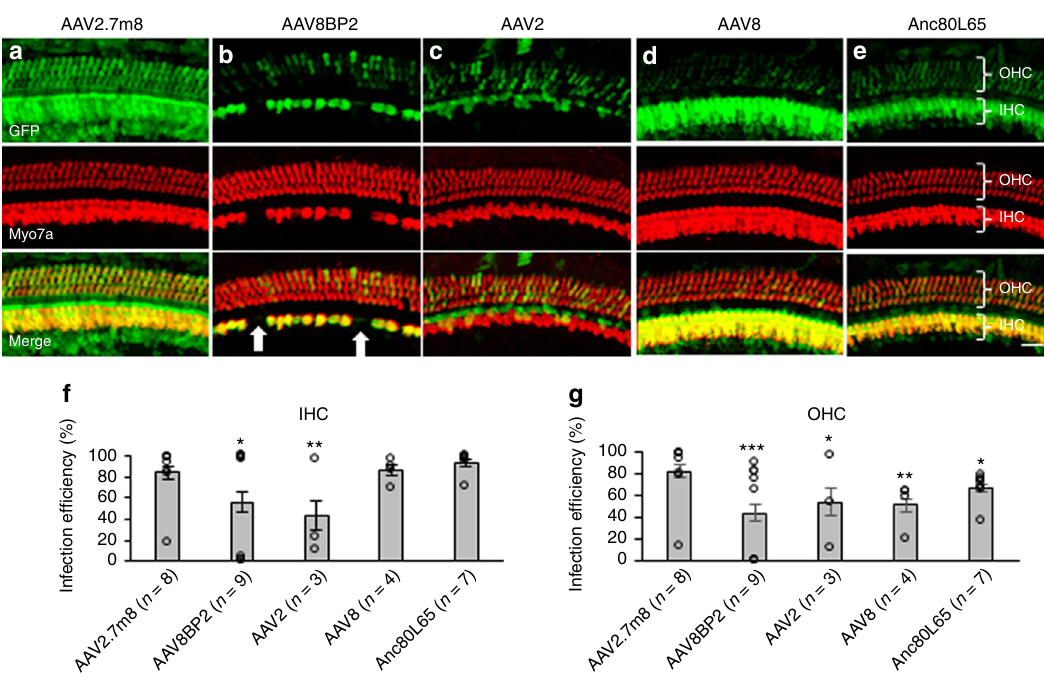
Fig. 1 AAV2.7m8 infects cochlear inner and outer hair cells with high ef fi ciency. a – e When AAV2.7m8-GFP ( a ) was injected into neonatal mouse inner ear via the posterior semicircular canal approach, the IHCs and OHCs were infected with high ef fi ciency throughout the entire cochlea. AAV8BP2-GFP ( b ) injection caused some loss in IHCs (white arrows). AAV2-GFP ( c ), AAV8-GFP ( d ), and Anc80L65-GFP ( e ) infected IHCs at high levels, but the OHC infection ef fi ciency was less than AAV2.7m8-GFP. GFP expression is shown in green and Myo7a expression (a marker for hair cells) is shown in red. 40x images of the cochlear apex are shown. Scale bar represents 20 μ m. f , g Quanti fi cation of IHC ( f ) and OHC ( g ) infection ef fi ciency. Open circles represent the average infection ef fi ciency of each animal. n represents the number of animals tested. For each animal, hair cell infection was quanti fi ed at six different locations along the cochlea: two at the apex, two at the middle turn, and two at the cochlear base. Error bars represent standard errors. Statistical signi fi cance with reference to AAV2.7m8 is shown above error bars (* represents p < 0.05, ** represents p < 0.01, and *** represents p < 0.001; t -test). Source data are provided as a Source Data fi le. IHC, inner hair cell; OHC, outer hair cell; p , p